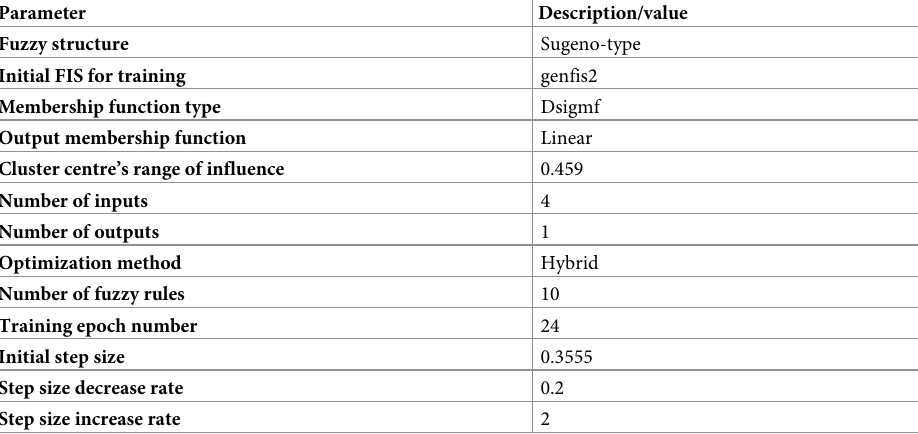
Table 3. Descriptions of the optimal ANFIS model hyperparameters.